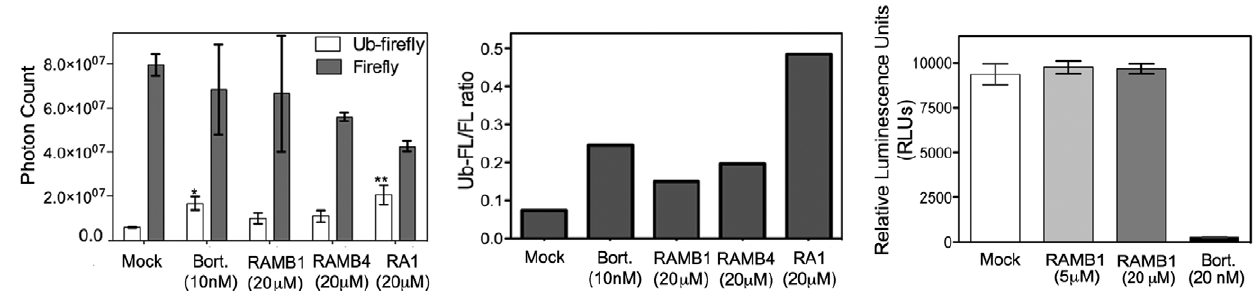
Figure 5. RAMB treatment fails to inhibit proteasomal activity in living cells. Left panel: Luciferase activity in lysates of Ub-FL or FL-vector transfected cells either with or without treatment with RAMB compounds or Bortezomib were quantified in Relative Luminescence Units (RLU) and expressed as % of control. Error bars are Standard Deviation (SD) for three independent experiments. Middle panel: Quantification of the Ub-FL/FL ratio. Right panel: Luminescence activity in cell lysates derived from CaSki cervical cancer cells with or without RAMB or Botezomib treatment quantified in Relative Luminescence Units (RLUs). *, P , 0.05, **, P , 0.02.